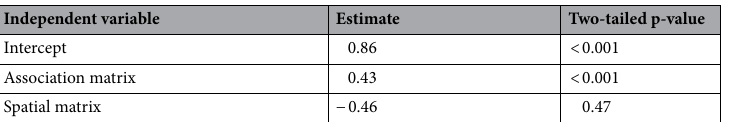
Table 3. Female BSI: model output from multiple regression quadratic assignment procedure (MRQAP). Pairwise female BSI was significantly correlated with the simple ratio index after controlling for the